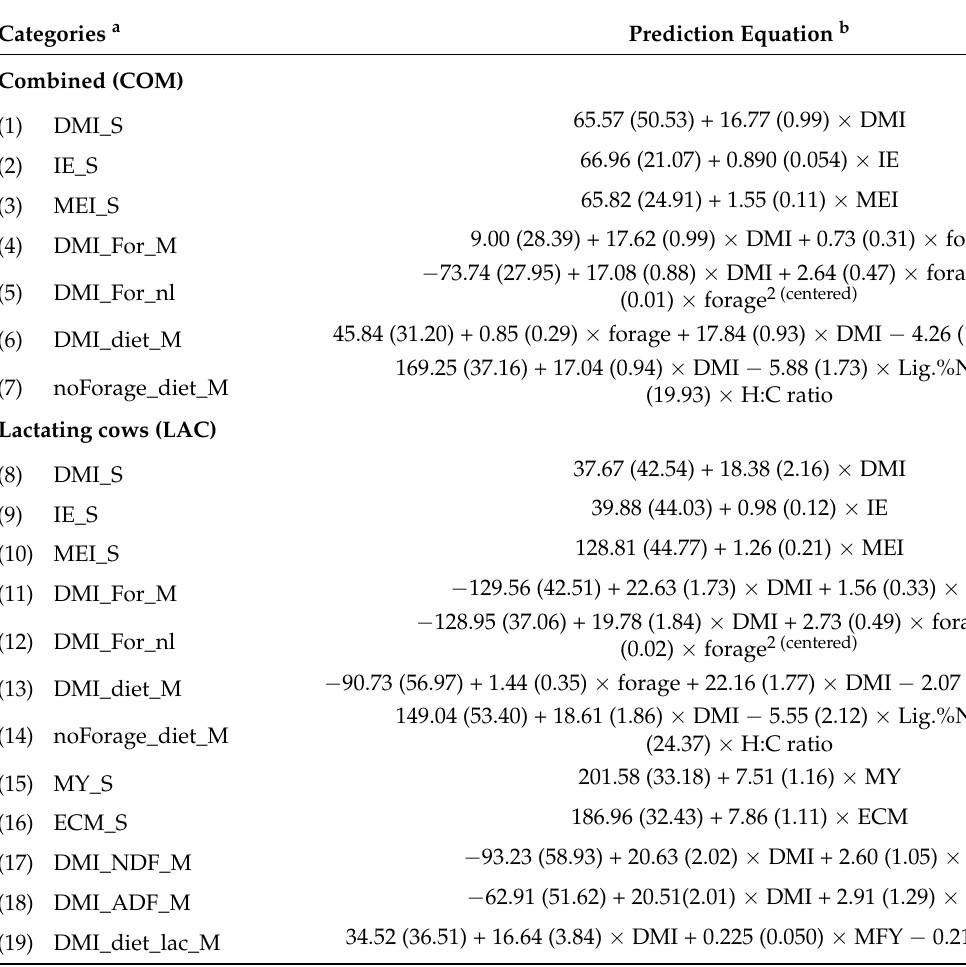
Model Performance